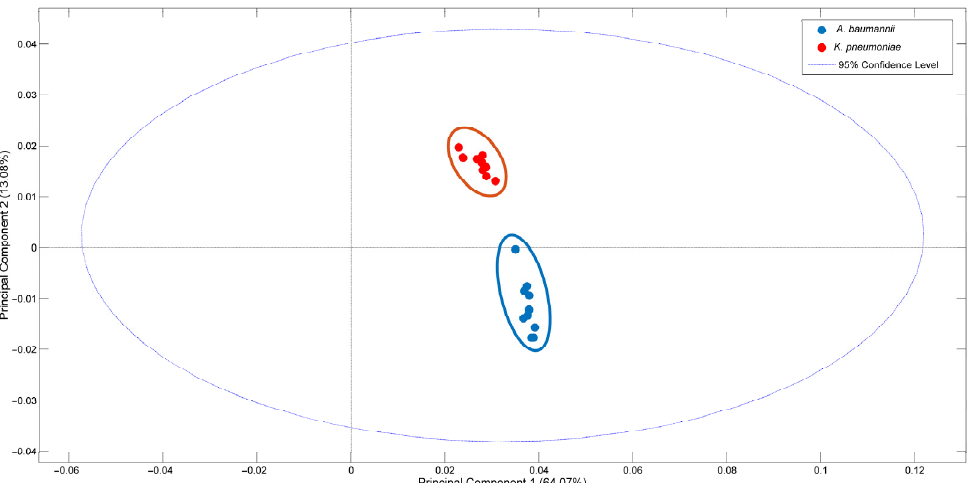
Figure 3. Discrimination of K. pneumoniae and A. baumannii species via SERS. Score plot of PCA model with the first two principal components (PCs) showing the differentiation of Raman spectra according to species.